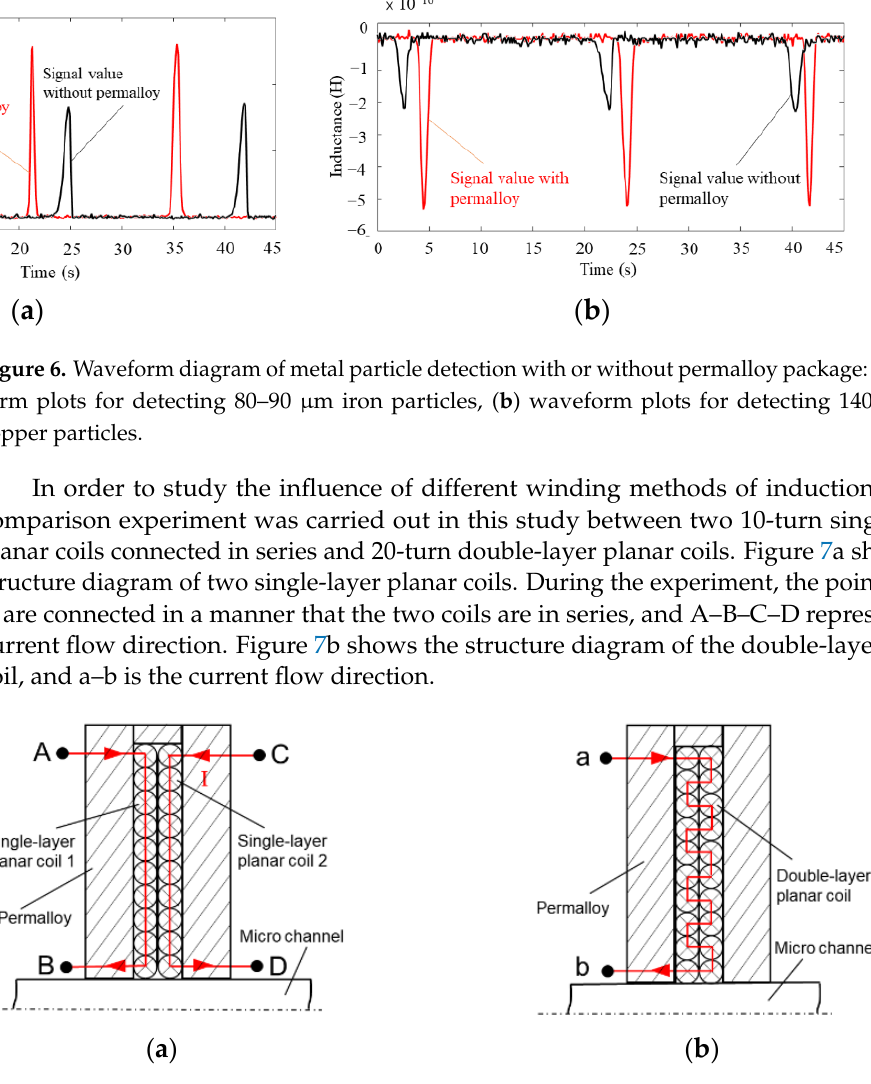
Figure 7. The difference between the two winding methods: ( a ) two planar coils in series, ( b ) double- layer planar coil.